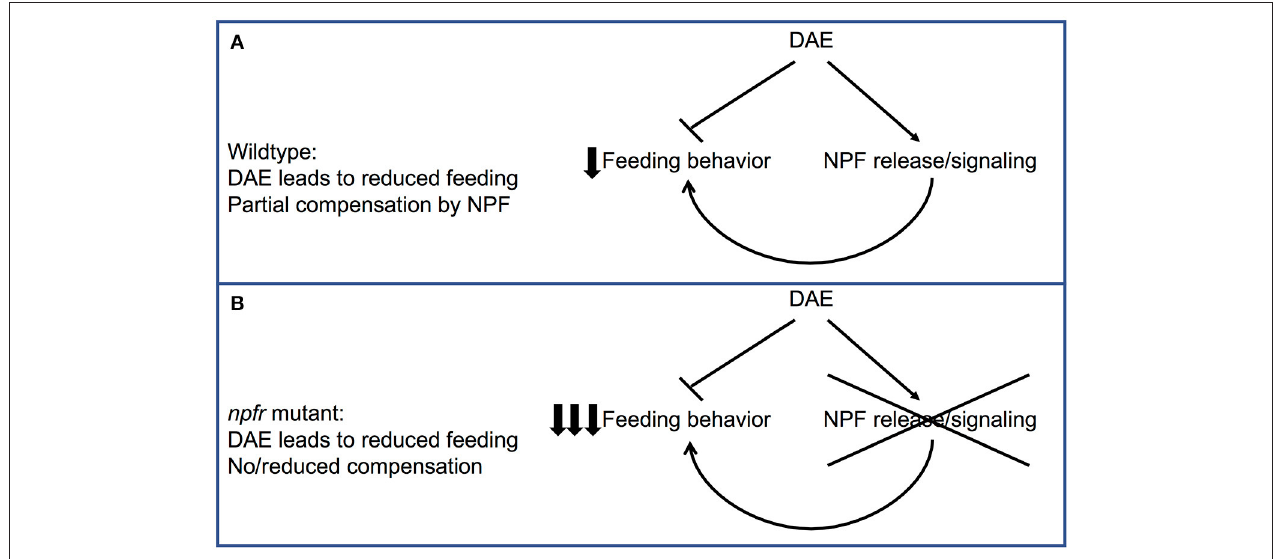
FIGURE 5 | Model for the effect of loss of NPF signaling on feeding in ethanol-supplemented larvae. (A) In wildtype animals, eating food containing ethanol leads to a decrease in feeding behavior as well as an increase in NPF release/signal transduction. This increase in NPF release would be expected to partially compensate for the effect of ethanol on feeding. (B) In npfr mutant animals, this compensatory upregulation in feeding behavior cannot occur, leading to a much larger reduction in